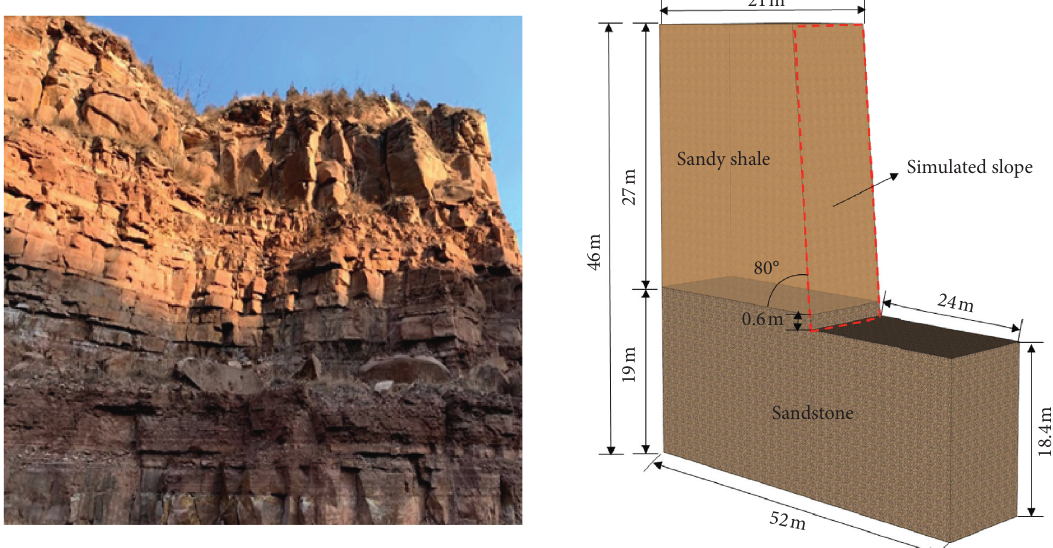
Figure 2: Site slope and model diagram of Jietai Temple.